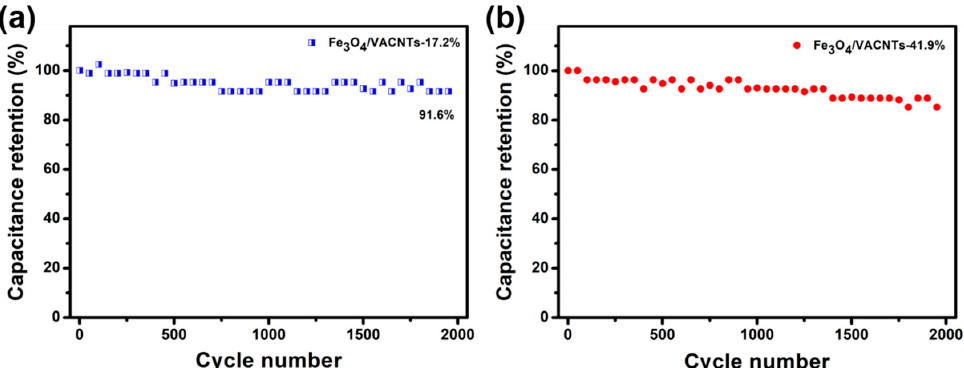
Figure 6. Cycling performance of the Fe 3 O 4 /VACNTs composites with different Fe 3 O 4 loading at a current density of 4 A g − 1 : ( a ) Fe 3 O 4 /VACNTs-17.2%; ( b ) Fe 3 O 4 /VACNTs-41.9%.